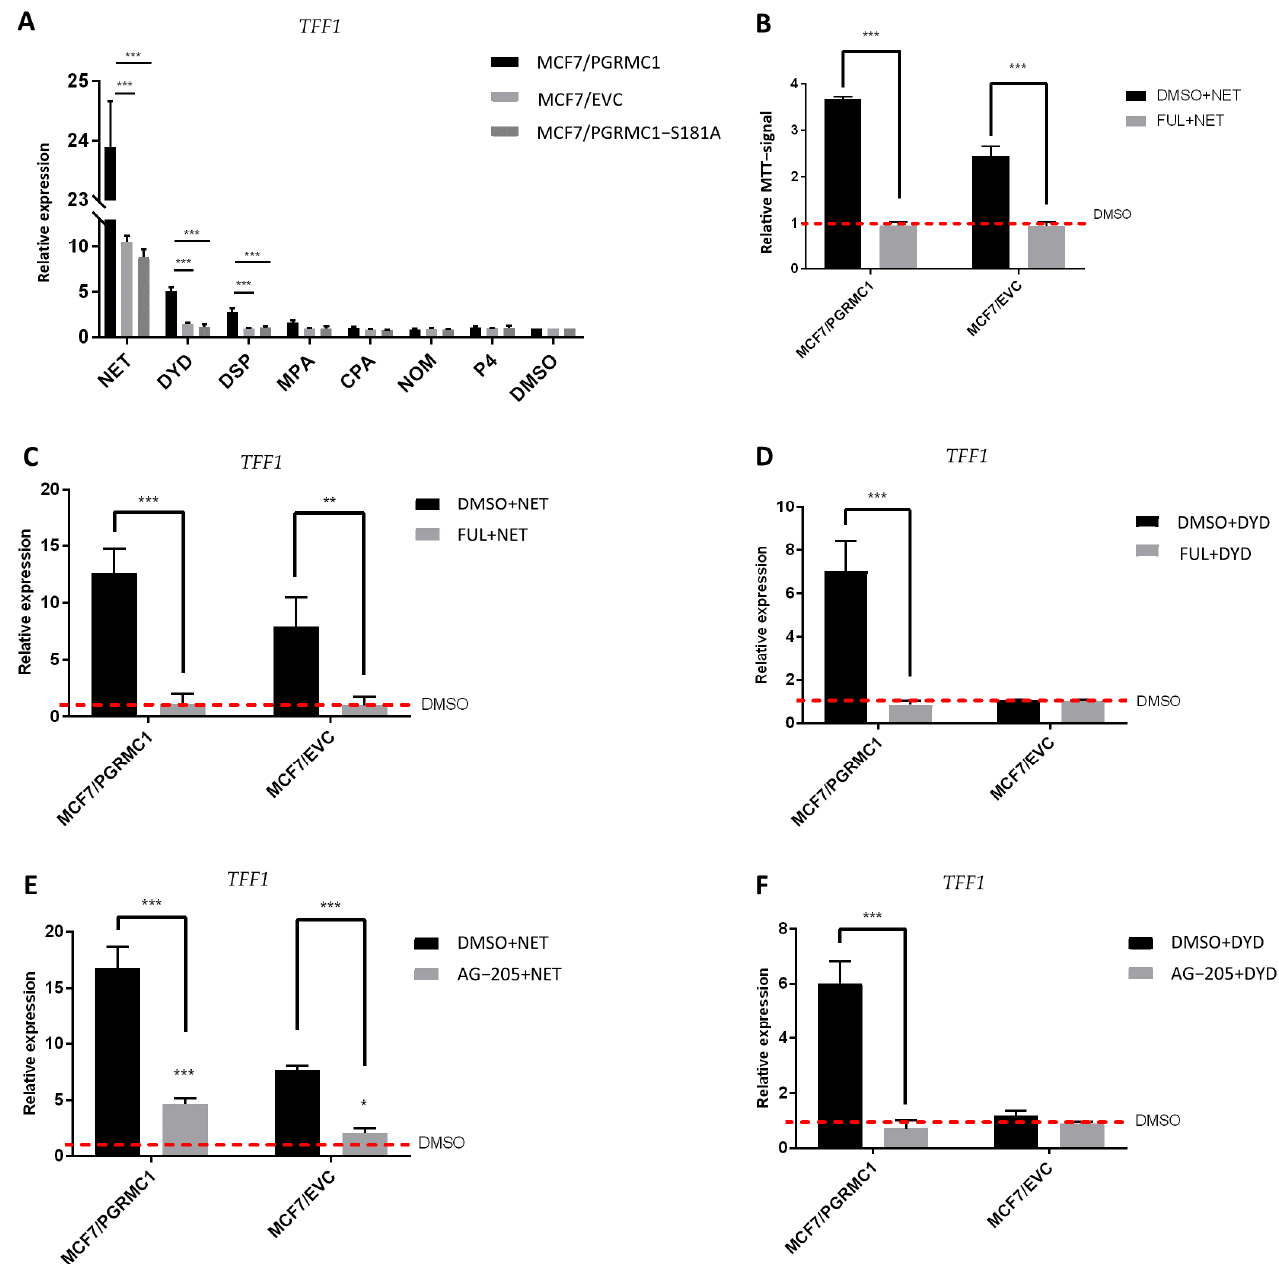
Figure 5. ER α is activated upon progestin-treatment in a PGRMC1-dependent manner. ( A ) qRT-PCR analysis of TFF1 mRNA expression in MCF7/PGRMC1, MCF7/EVC and MCF7/PGRMC1-S181A cells upon treatment with progestins (10 − 6 M) or DMSO (0.01%) for 24 h. ( B ) Relative MTT signal as surrogate for cell number of MCF7/PGRMC1 and MCF7/EVC cells treated with fulvestrant (10 − 7 M) and NET (10 − 6 M) or DMSO (0.01%). Values were normalized to DMSO treated cells. qRT-PCR analysis of TFF1 mRNA expression in MCF7/PGRMC1 and MCF7/EVC cells upon treatment with ( C ) fulvestrant (10 − 7 M) and NET (10 − 6 M), ( D ) fulvestrant and DYD (10 − 6 M), ( E ) AG-205 (25 × 10 − 6 M) and NET, ( F ) AG-205 and DYD, or DMSO, respectively. Signal intensity was normalized to respective DMSO control. Statistical analysis was performed by two-way ANOVA and Bonferroni post-hoc test. *: p < 0.05, **: p < 0.01, ***: p < 0.001.